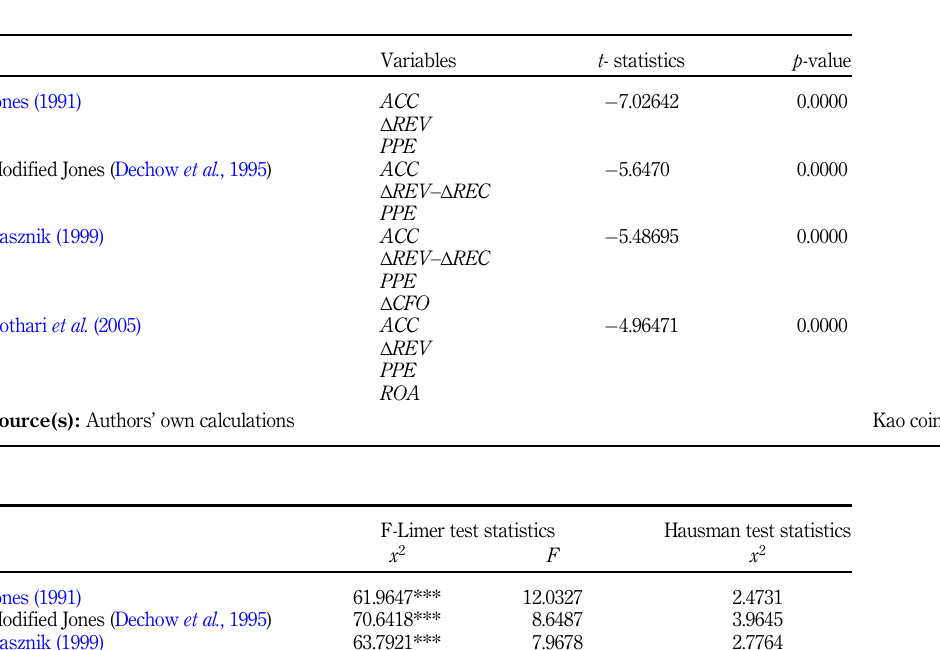
Table 5. F-Limer